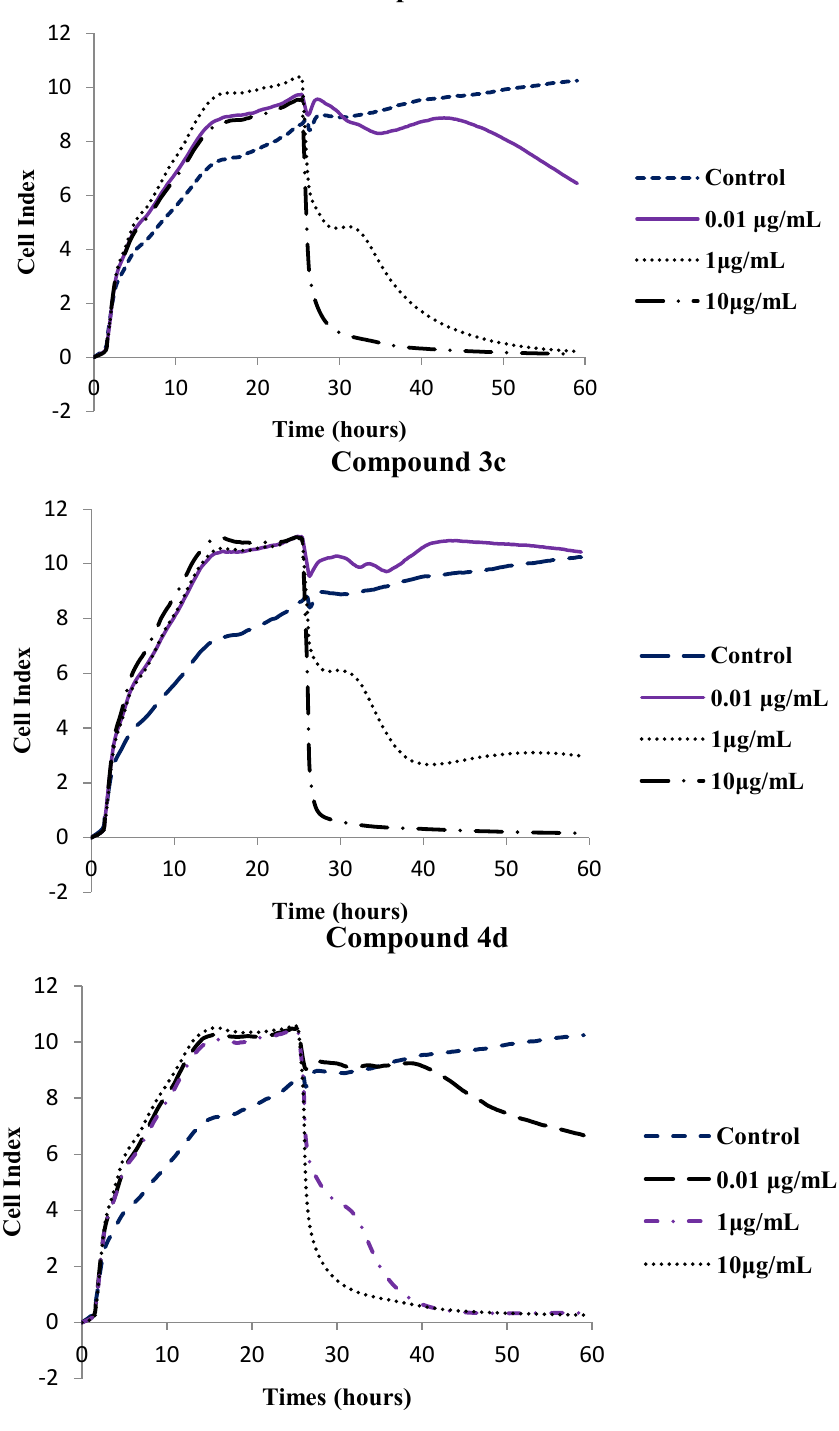
Figure 3. In vitro anti-proliferative effects of compounds 2 , 3a , 4d and Nocodazole on human breast cancer cells at concentrations 0.01, 1 and 10 μg/mL against 0.001% DMSO using the xCELLigence Real Time Cell Analysis System. Cell Index (CI) values are normalized to the time point of compound administration, showing a dose- and time-dependent antigrowth